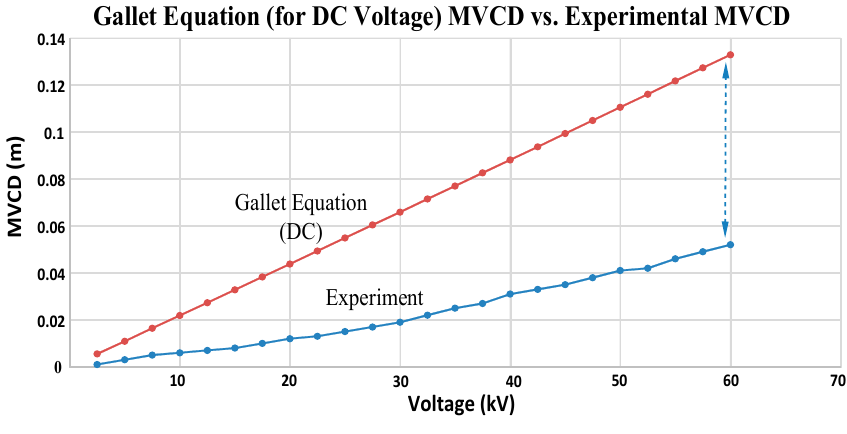
Figure 4. Experimental MVCD values at different voltages.